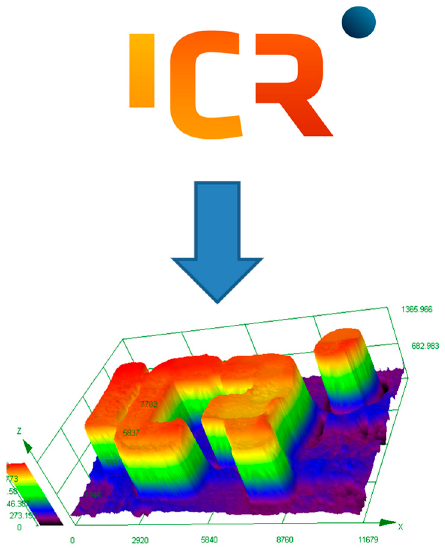
Figure 6. Numerical optical microscope observation of patterns “ICR” written from the polymerization of trimethylolpropane triacrylate (TMPTA) with the iodonium 5 in combination with trimethylaniline (TMA) (1% / 1% w / w ): 3D overall appearance. A writer using a laser diode at 405 nm (size of the spot around 50 µ m) with the intensity of 100 mW was used for the spatially controlled irradiation.